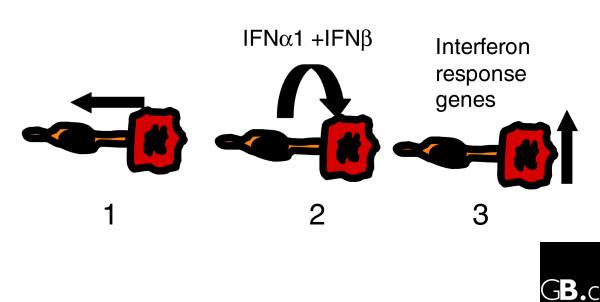
Model of interaction effects. Upon close cell-cell contact the tumor cells (red) interact with the fibroblasts (yellow) (1), which express type I interferon (IFNα and IFNβ) (2). They in turn induce the interferon response genes predominantly in the tumor cells (3).